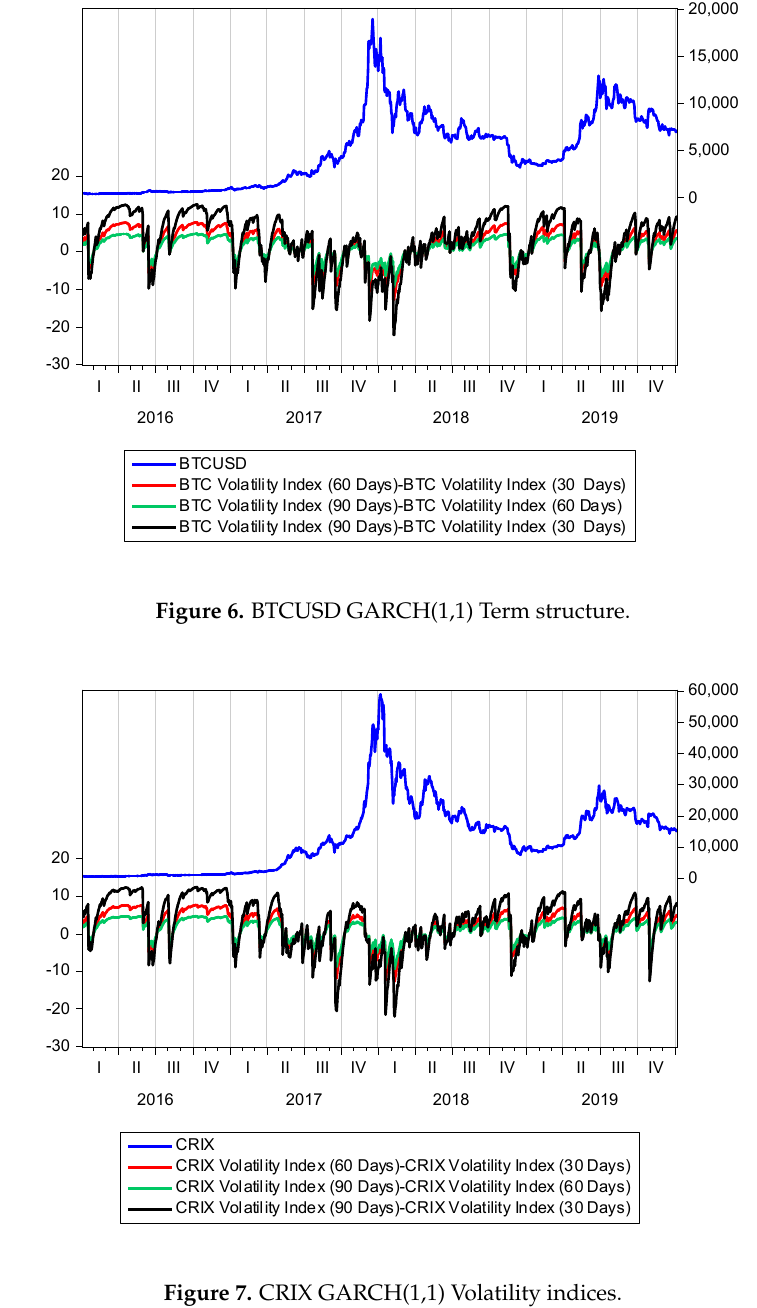
Figure 7. CRIX GARCH(1,1) Volatility